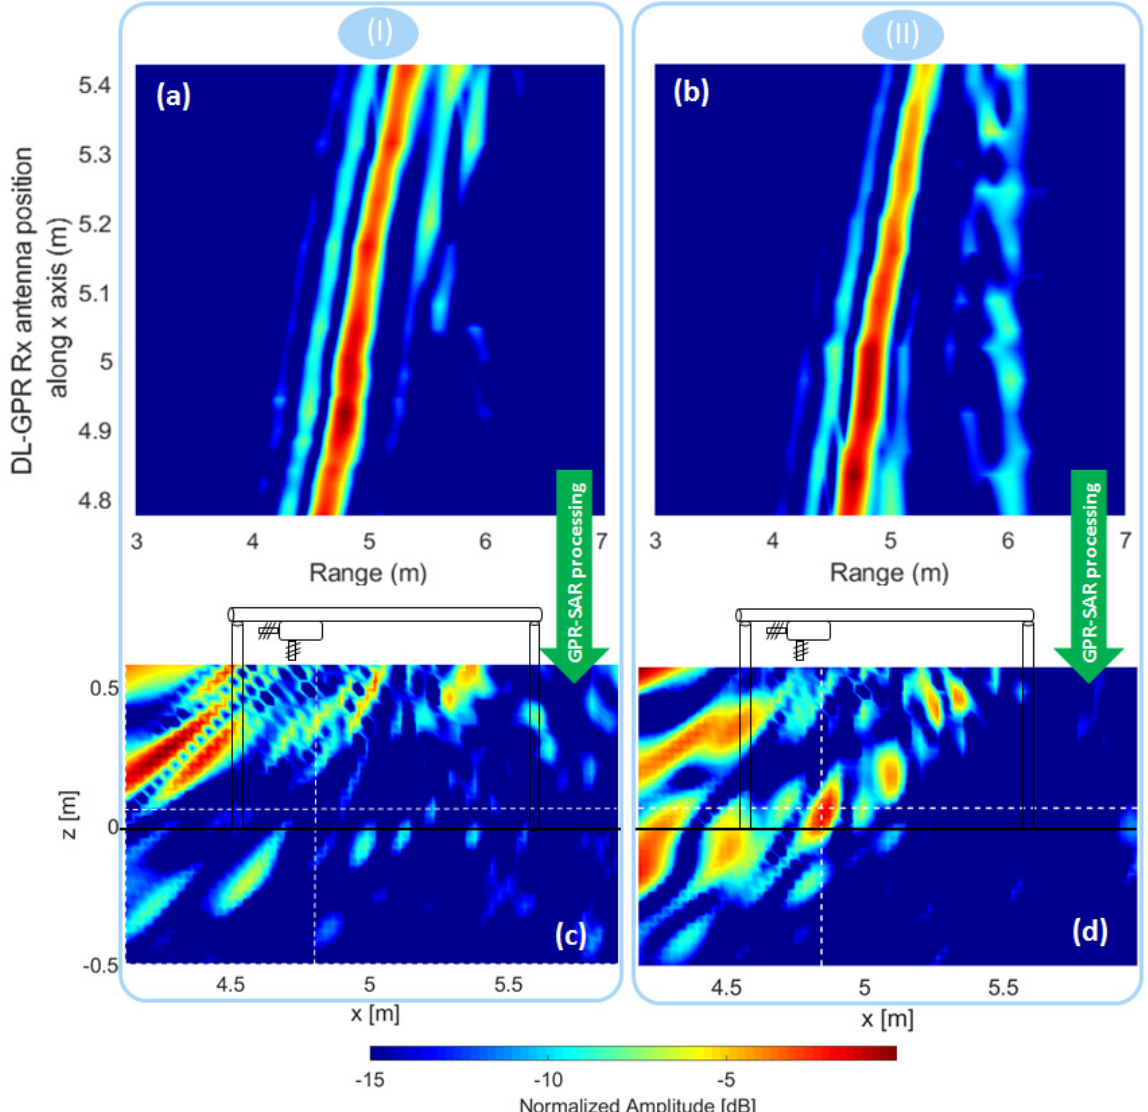
Figure 8. Individual processing of the cuts corresponding to the x -axis sweeps highlighted with dashed yellow rectangles in Figure 7, not intersecting (I) and intersecting (II) the position of the metallic can. ( a ) and ( b ) correspond to the range measurements for each acquisition position along the x -axis, and ( c ) and ( d ) are the reflectivity images in the XZ plane after applying GPR-SAR processing. For reference purposes, the air–ground interface ( z = 0 m) and a sketch of the layout of the portable setup are depicted in black color in ( c ) and ( d ).